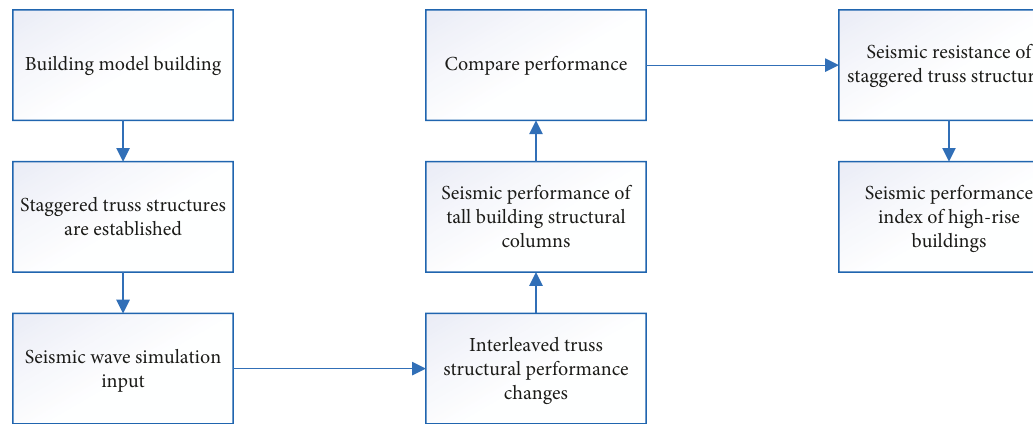
Figure 2: Experimental process of evaluating the earthquake-resistance ability of the structure column.